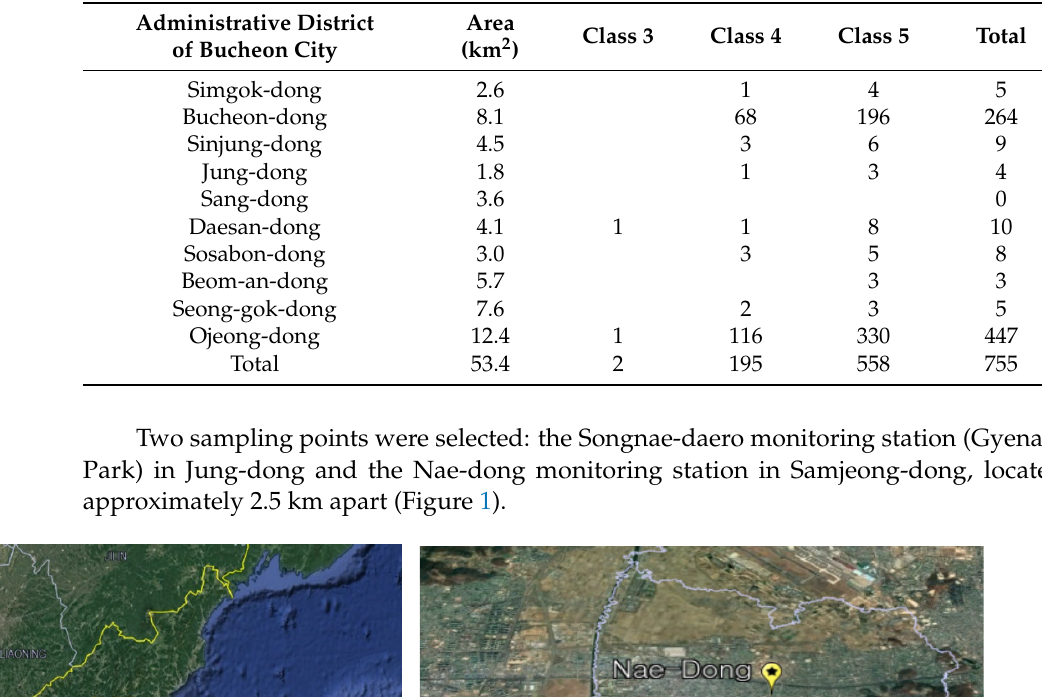
Table 1. Air-pollutant-emitting facilities in Bucheon City [8].